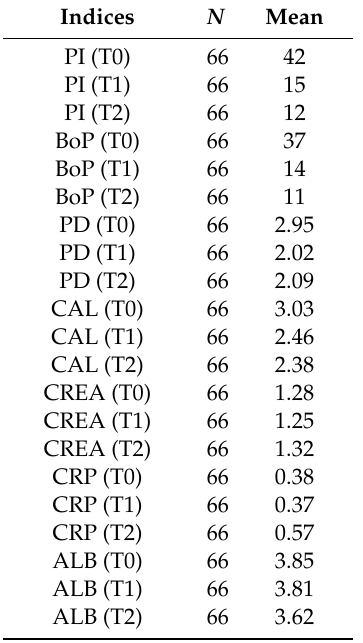
Table 1. Descriptive analysis of variables at three time points.